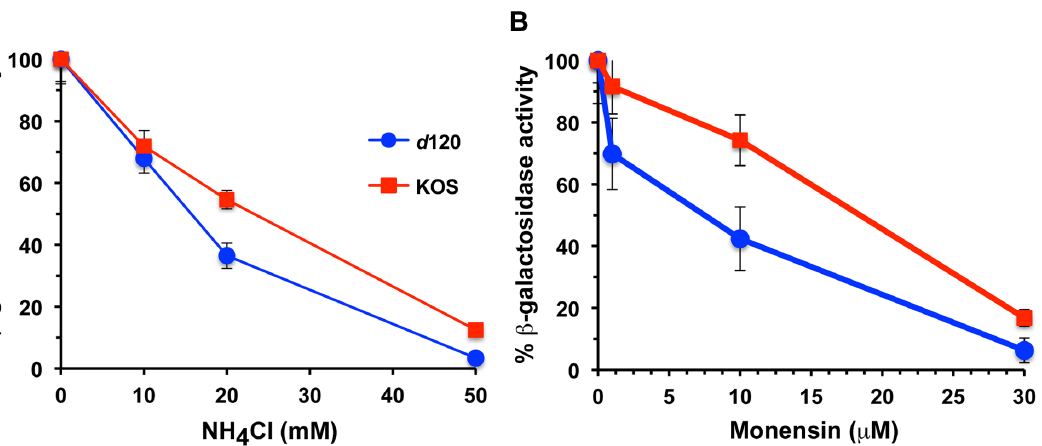
Figure 5. HSV-1 d 120 enters cells via an acid-dependent endocytosis pathway. CHO-nectin-1 cells were treated with the indicated concentrations of (A) ammonium chloride (NH 4 Cl) or (B) monensin for 20 min at 37 u C. Equivalent genome copy numbers of HSV-1 KOS or d 120 virions were added for 6 to 7 hr at 37 u C in the constant presence of agent. The percent beta-galactosidase activity relative to that obtained in the absence of agent is indicated. The data are means of quadruplicate determinations with standard deviation. Experiments were performed at least three times with similar results. Entry of d 120 in the presence of NH 4 Cl or monensin was not statistically different from KOS wild type (p=0.787 or p=0.579, respectively, Student’s t-test).